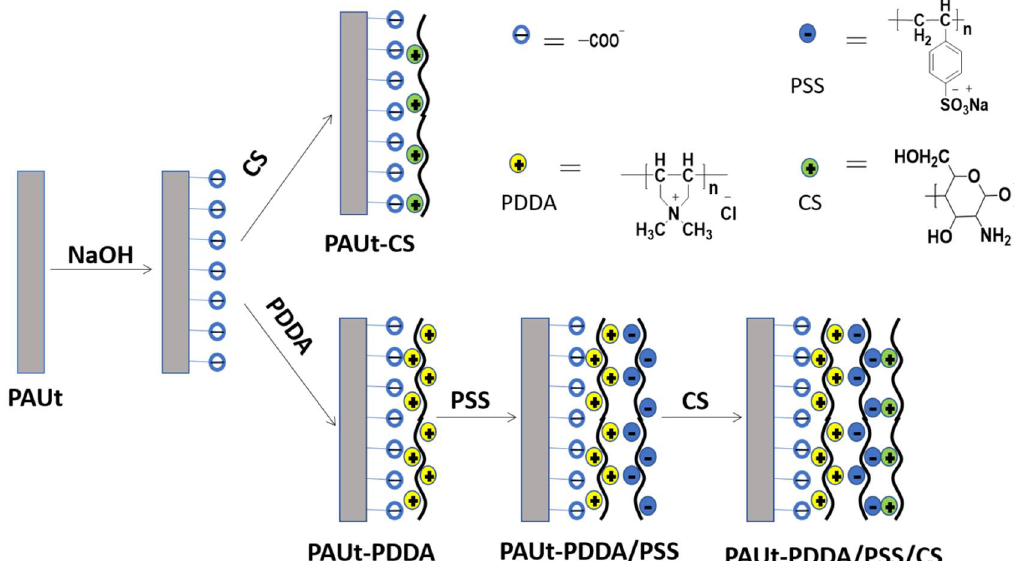
Figure 1. The schematic drawing process for modification of the selective separation layer of PAUt membrane.